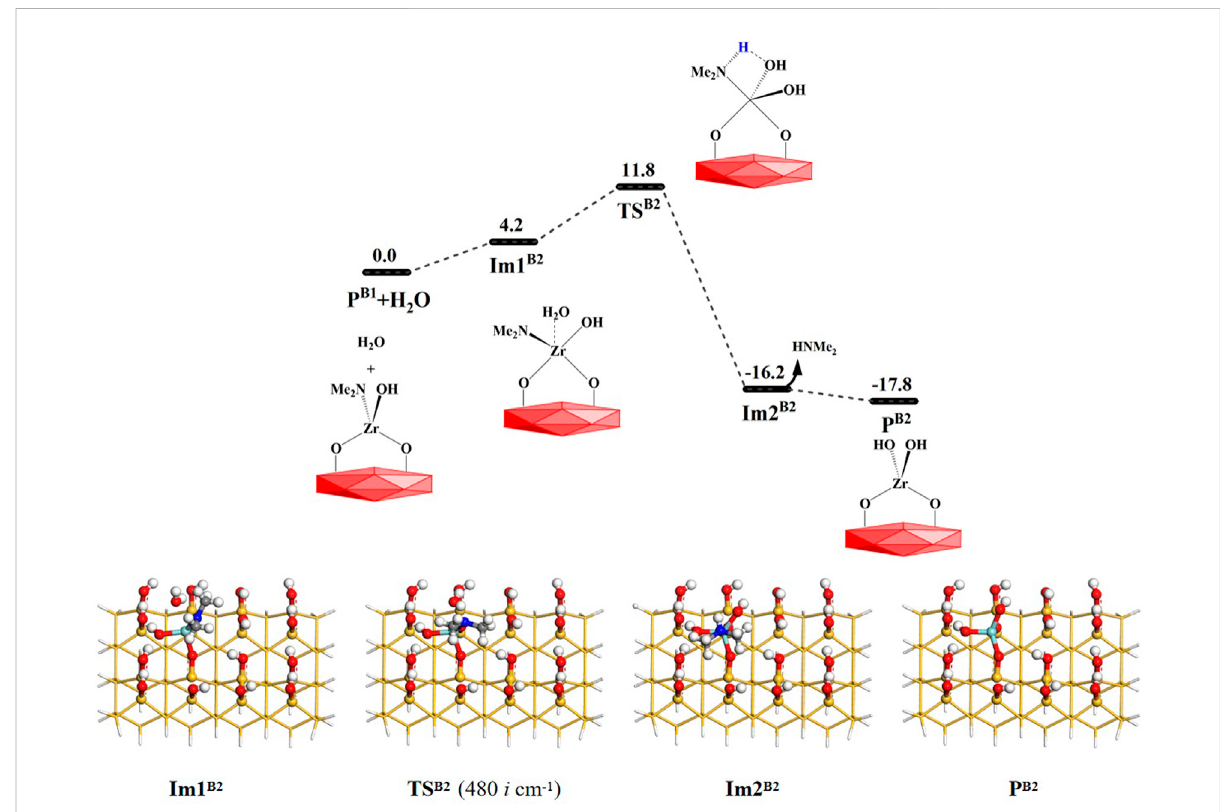
FIGURE 6 Gibbs free energy ( Δ G , kcal/mol) pro fi les of the B2 section of the H 2 O reaction with the aminated